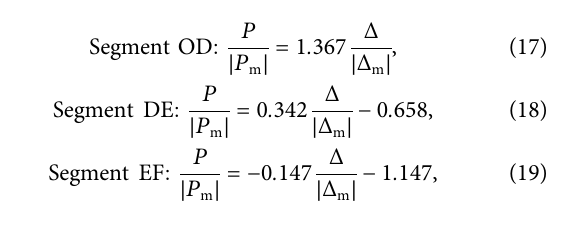
The regression analysis process is shown in Supplementary Figure S5 . Where, Δ i / Δ y represents the displacement cycle grade, and K i / K u represents the ratio of the stiffness under displacement cycle to failure stiffness of specimens.